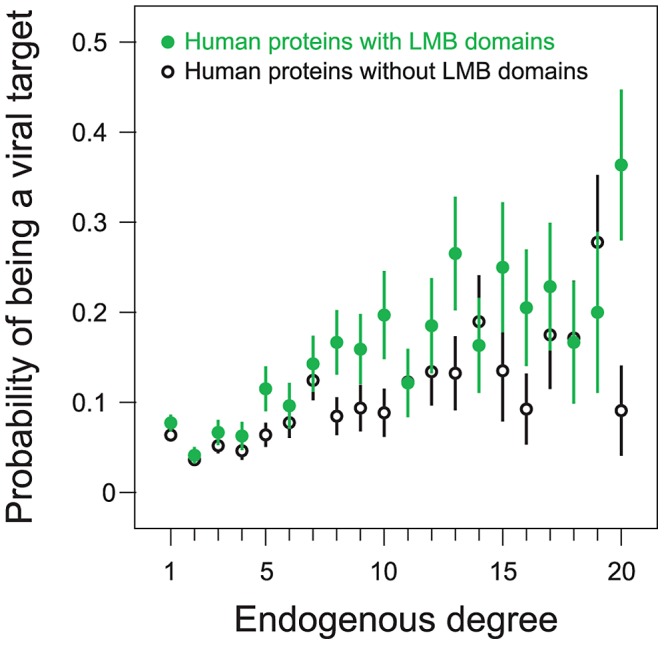
Preferential targeting of LMB domains by viruses is independent of host protein degree.We partitioned human proteins into LMB domain-containing proteins (filled green points), and LMB domain-free proteins (open black points). We further divided proteins according to endogenous degree. 92% of all human proteins in the network fall into one of the degree 1–20 bins; each bin contains at least 20 proteins. The probability of being a viral target increases with degree for both LMB domain-containing and LMB domain-free proteins. For a given degree, LMB domain-containing proteins are more likely to be viral targets than LMB domain-free proteins.